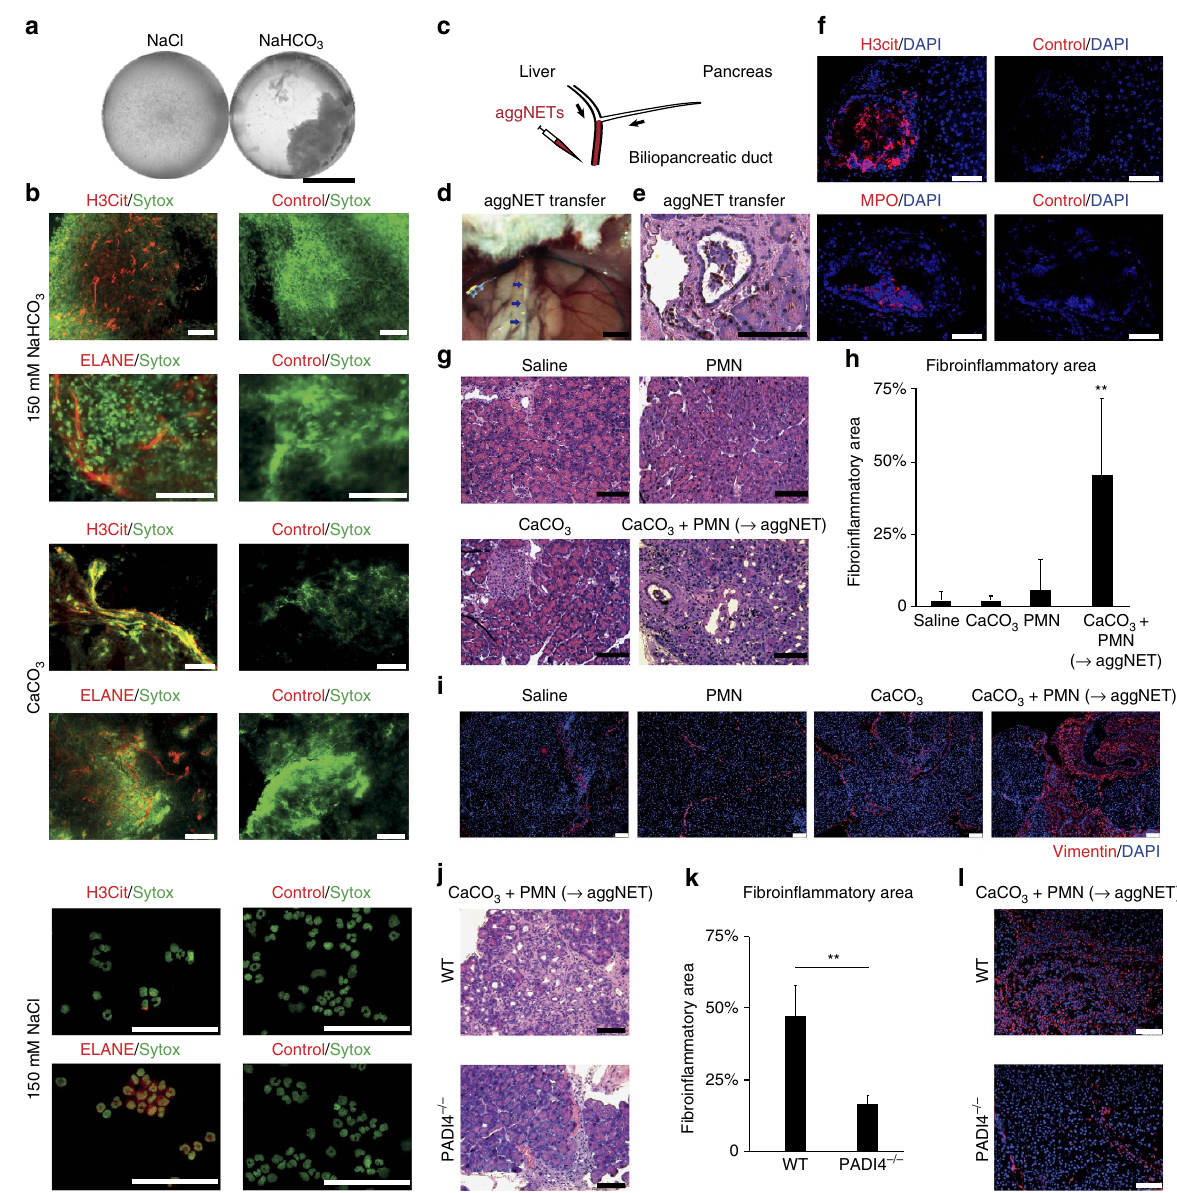
Figure 5 | Intraductal formation of carbonate-induced aggNETs causes segmental pancreatic atrophy. ( a – c ) Neutrophil-rich peritonitis was induced in mice by means of intraperitoneal thioglycolate injection. After 18h, 2ml of 150mM sodium bicarbonate, calcium carbonate crystals (20mg) or 2ml of saline control were injected into the peritoneal cavity. Thirty minutes later, a peritoneal HBSS lavage was aspirated, aggregates were collected and processed for consecutive immunocytochemistry; ( a ) note that aggNETs visible to the naked eye could only be aspirated after injection of NaHCO 3 but not in saline control ( b ). Carbonate-induced aggNETs formed in vivo were immunopositive for citrullinated histone H3 and neutrophil elastase (ELANE) (three independent experiments of a total of n ¼ 6 per group). ( c ) Model of the aggNET transfer technique. We carefully transferred calcium carbonate crystals (0.5mg) and thioglycolate-induced neutrophils (10 6 cells) in 10 m l each to the biliopancreatic duct to form aggNETs in situ , as well as saline or single- component controls. The biliary duct was ligated with a suture close to the liver hilus. ( d ) Intraoperative situs post aggNETtransfer. The biliopancreatic duct filled with aggNETs and the stomach are marked by arrows and asterisks, respectively (bar, 10mm). ( e ) Pancreatic duct filled with an aggregate after in situ aggNET formation (bar, 100 m m). ( f ) Immunohistochemical detection of citrullinated histone and myeloperoxidase in intraductal aggNETs 4h after aggNET transfer. ( g ) Haematoxylin and eosin staining and ( i ) vimentin immunohistochemistry revealed the marked segmental fibroinflammatory area and mesenchymal cell expansion 6 days after aggNET transfer. ( h ) The sectional area of the pancreas affected by fibroinflammatory remodelling 6 days after aggNET transfer was calculated for each experimental group (two independent experiments, n ¼ 6 per group, mean þ s.e.m., ** P o 0.01 one-way analysis of variance/ post hoc Tukey honest significant difference analysis). ( j – l ) Crystals and neutrophil preparations of PADI4-deficient and wild-type mice were placed in biliopancreatic ducts of the respective recipients of the same genotype (two independent experiments, n ¼ 9 per group, ** P o 0.01 Student’s t -test). In both experimental groups, fibroinflammatory remodelling was evident ( j ), yet the affected fibroinflammatory area was markedly reduced in PADI4-deficient mice (mean þ s.e.m.) ( k ). Mesenchymal expansion as assessed by vimentin immunohistochemistry was attenuated as compared with wild-type controls ( l ). Black scale bars, 200 m m; white scale bars, 50 m m, unless stated